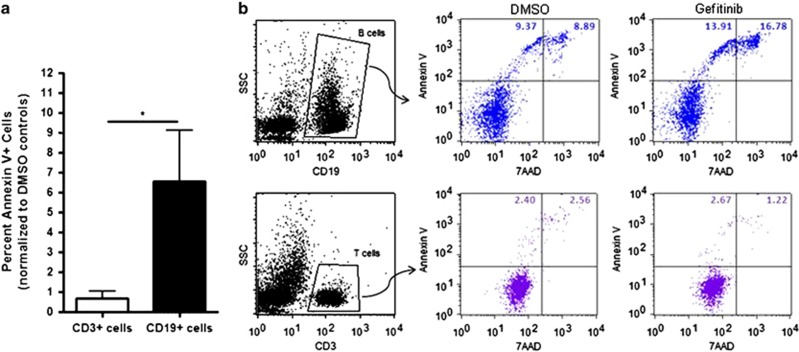
Gefitinib targets ZAP-70+ CLL cells but not ZAP-70+ T cells. (a) Percent Annexin V+ T cells and CLL cells from 4 different patients treated with 10 μM gefitinib for 24 h as analyzed by flow cytometry. Graphed with standard errors and analyzed by Mann–Whitney test. (b) Flow cytometry plots of Annexin V-FITC and 7AAD+ CLL cells (gated as CD19-APC+ cells) or T cells (gated as CD3-PE+). *P<0.05